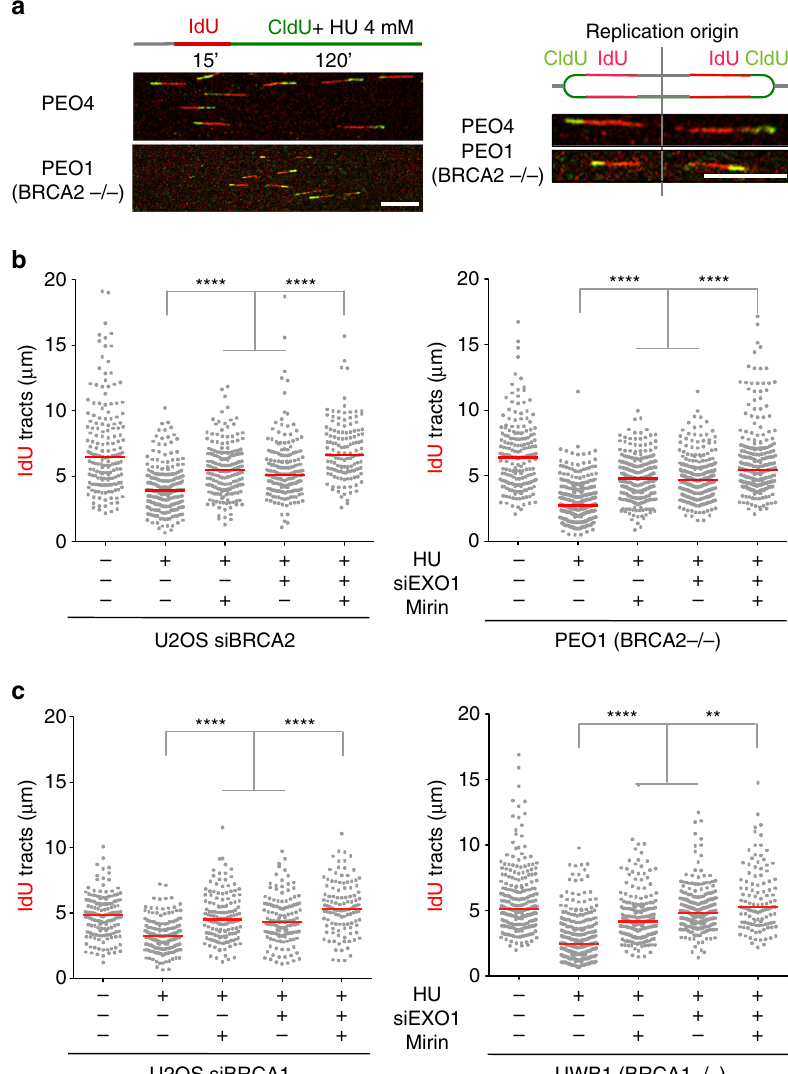
Fig. 1 MRE11 and EXO1 mediate extended nascent strand degradation in HU-treated BRCA1- and BRCA2-de fi cient cancer cells. a Schematic of the single- molecule DNA fi ber tract analysis and representative DNA fi ber images of PEO4 and PEO1 cells treated with HU (4 mM) for 120 min. IdU, red; CldU, green. Scale bar, 50 μ m. b Size distribution of IdU tract length in BRCA2-de fi cient U2OS (left) and PEO1 (right) cells in the presence and absence of HU. Cells were transfected with control siRNA or EXO1 siRNA before IdU and CldU labeling. Mirin (50 μ M) was added concomitantly with HU treatment, as indicated. Out of 3 repeats; n ≥ 250 tracts scored for each data set. Bars represent the median. Statistics: Mann – Whitney; **** P < 0.0001. c Size distribution of IdU tract length in BRCA1-de fi cient U2OS (left) and UWB1 (right) cells in the presence and absence of HU. Cells were transfected with control siRNA or EXO1 siRNA before IdU and CldU labeling. Mirin (50 μ M) was added concomitantly with HU treatment, as indicated. Out of 2 repeats; n ≥ 250 tracts scored for each data set. Bars represent the median. Statistics: Mann – Whitney; ** P < 0.01; **** P <